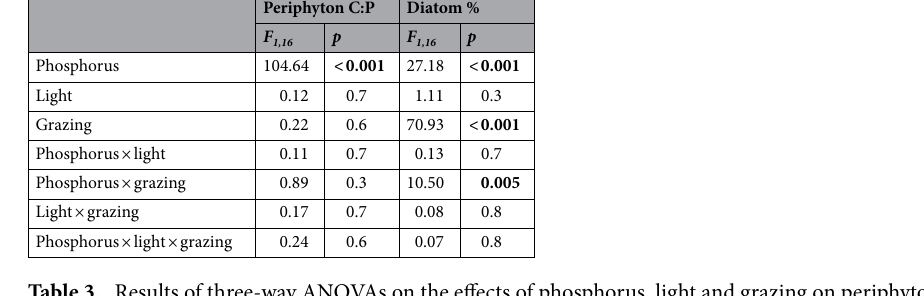
Table 3. Results of three-way ANOVAs on the effects of phosphorus, light and grazing on periphyton C:P ratio and diatom percentage contribution to total chlorophyll a at the end of the grazing phase. Significant effects ( p < 0.05) are highlighted in